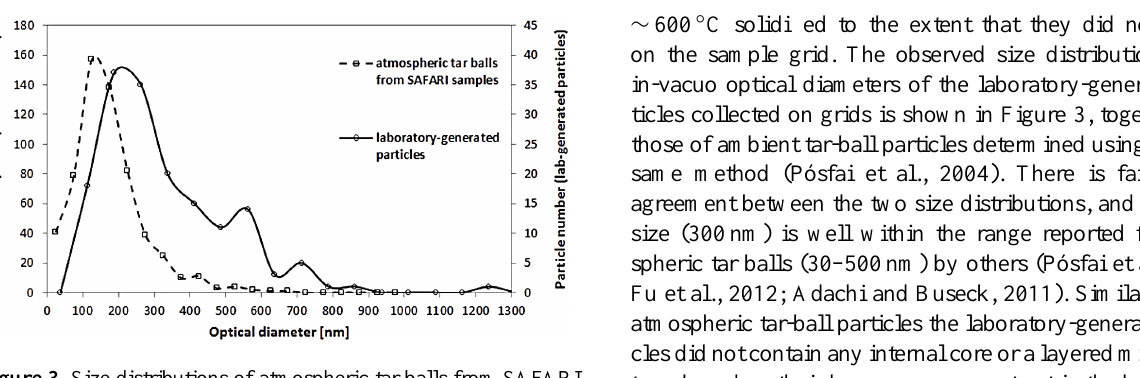
Figure 3. Size distributions of atmospheric tar balls from SAFARI samples (Pósfai et al., 2004) and laboratory-generated